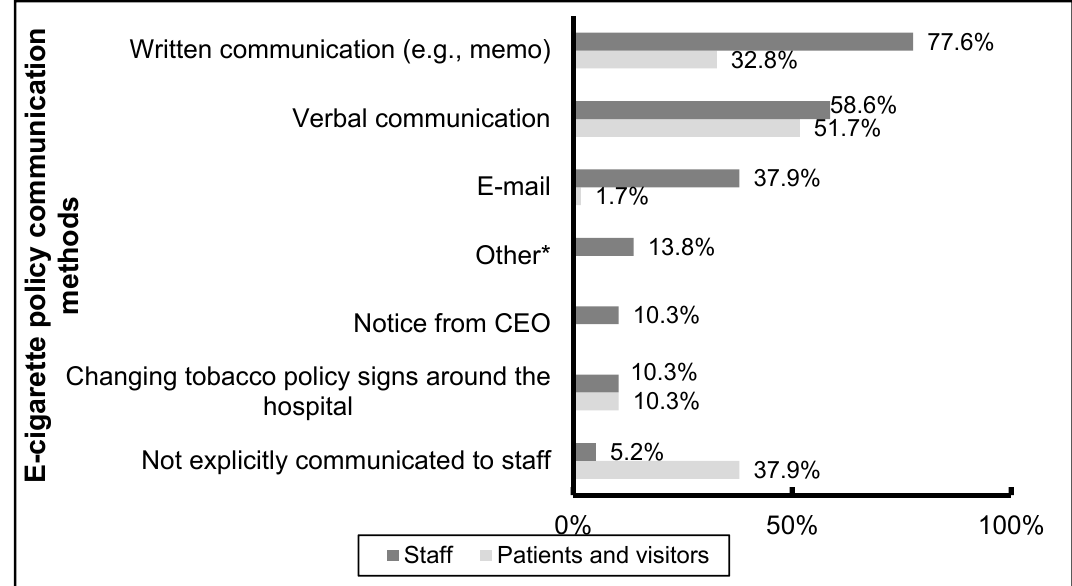
Figure 4. E-cigarette policy communication methods ( n = 58). * Other includes communication through staff meetings and policy revision updates.